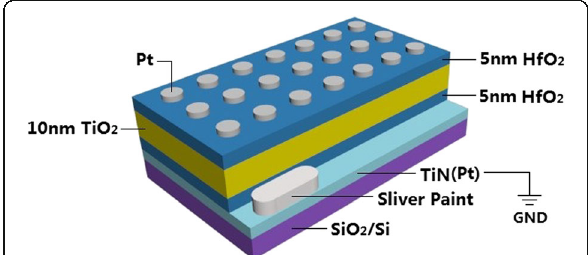
Fig. 1 The schematic of the RRAM device of HfO 2 /TiO 2 /HfO 2 trilayer- structure by